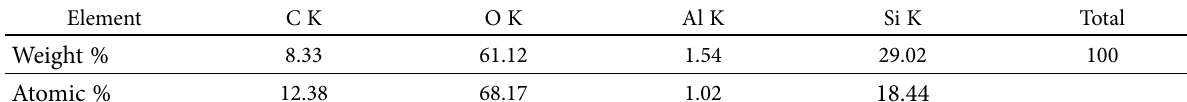
Table 4. Composition of fly ash after used in photo-Fenton process Element C K Weight